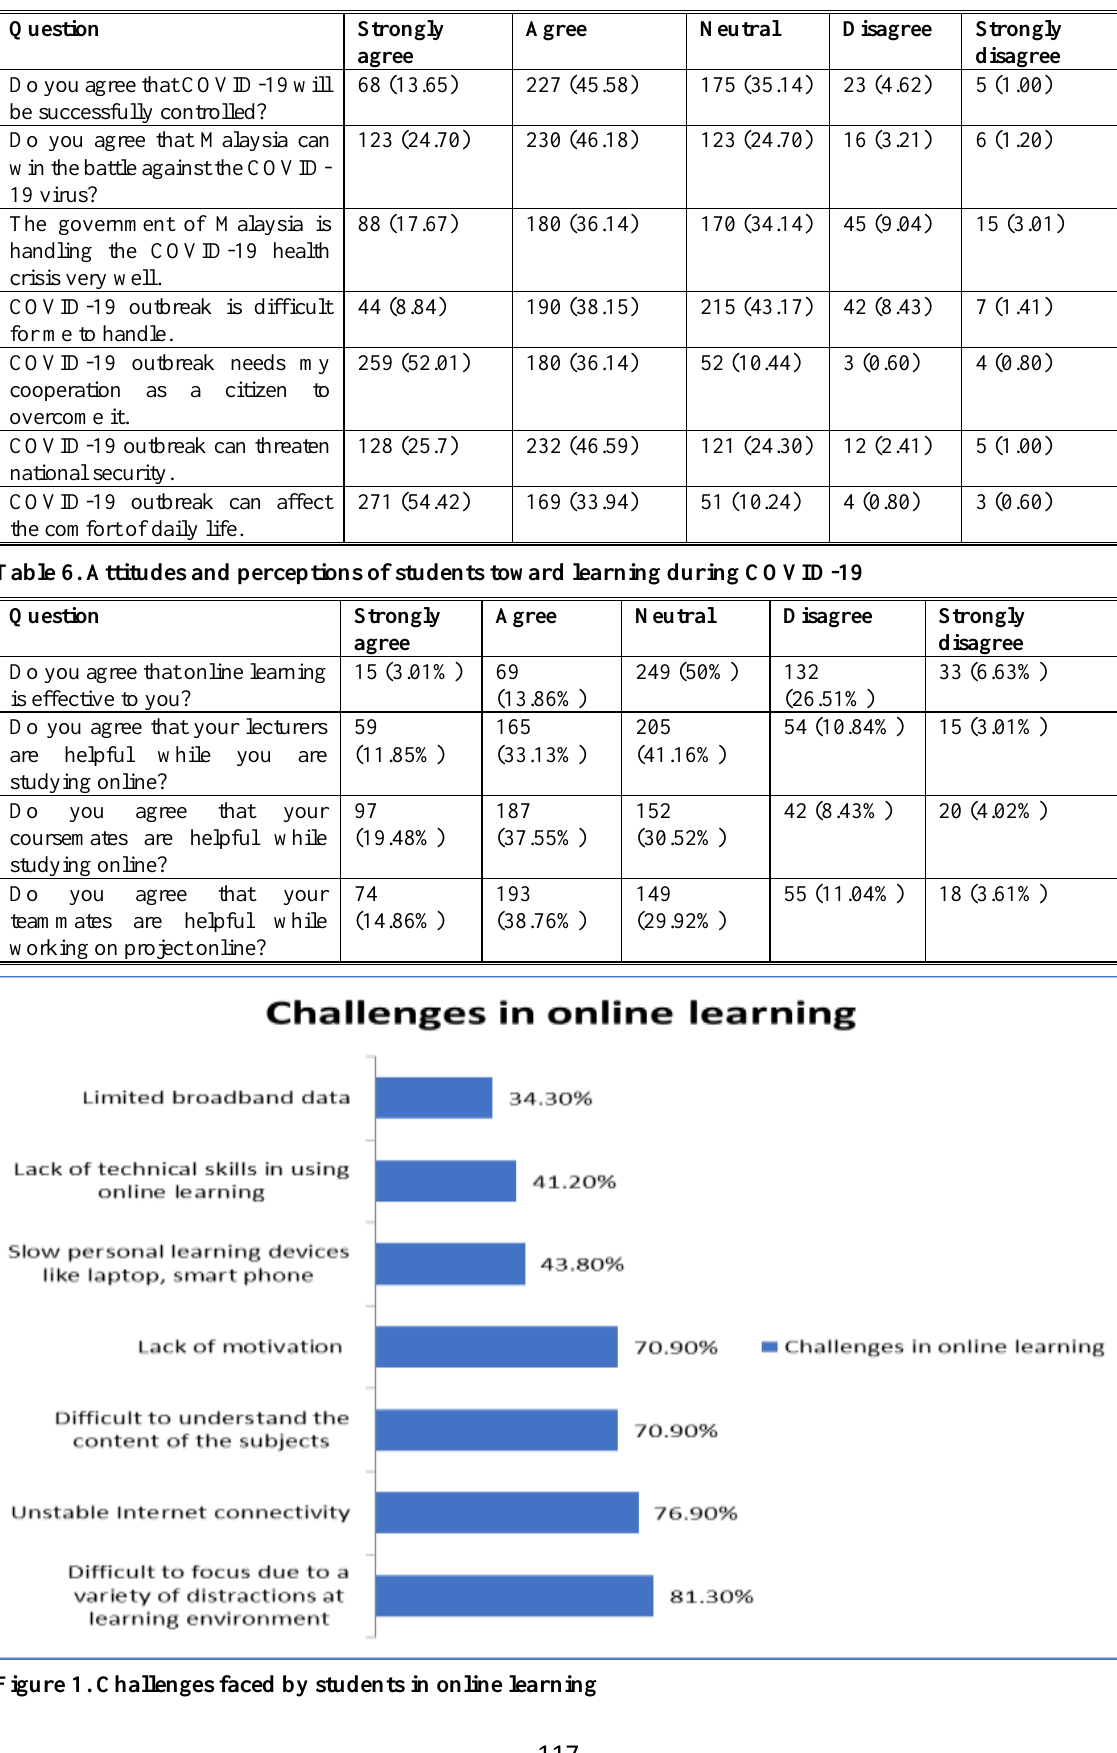
Table 5. Attitudes and perceptions of the participated students toward COVID-19